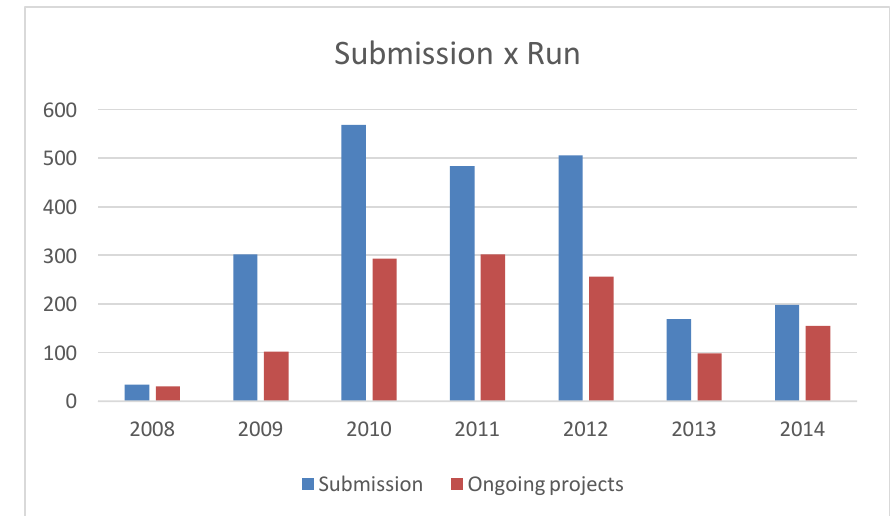
Fig. 6 . Submission x ongoing projects (ANEEL, march